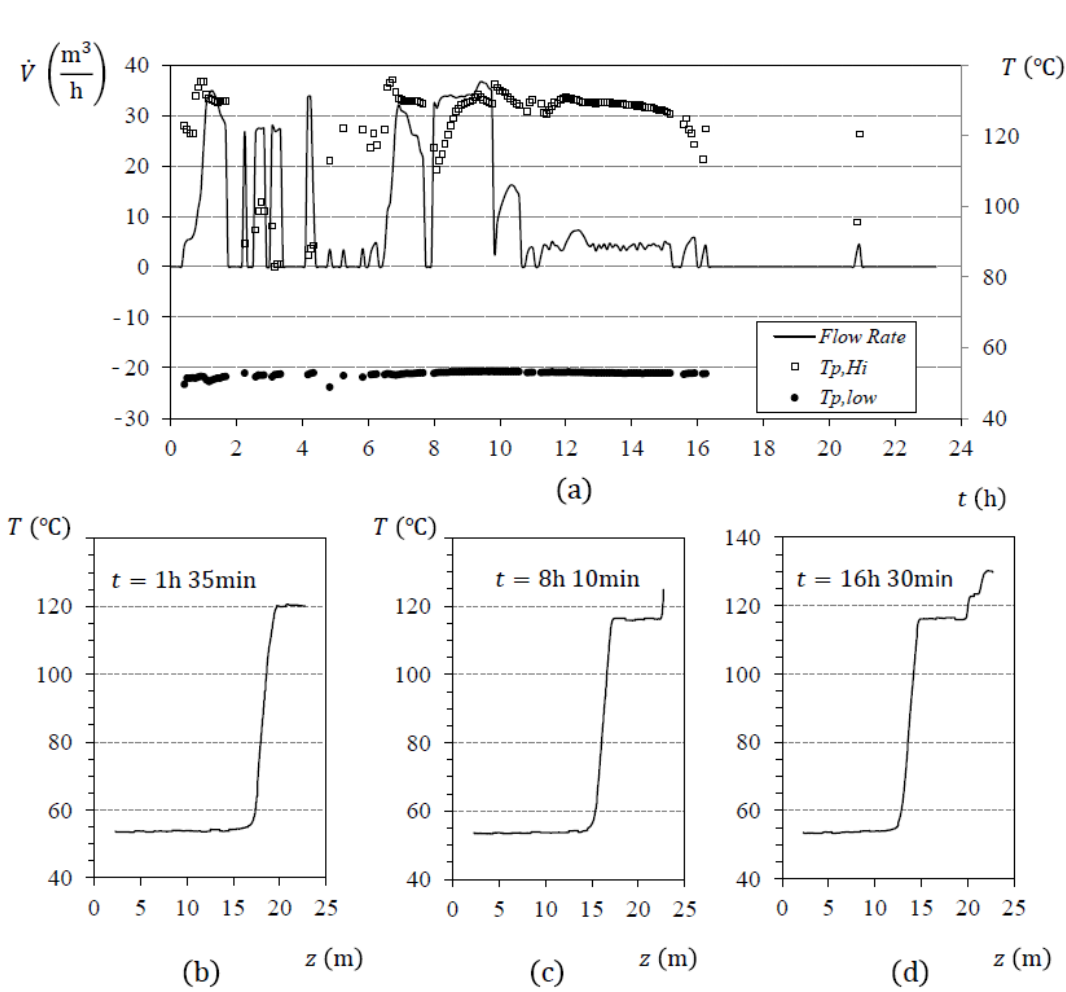
Figure 8. ( a ) Flow rate and pipe temperatures in a 24 h period with double temperature step generation. Temperature profiles at: ( b ) 1 h 30 min; ( c ) after 8 h; when colder water inlet promoted temperature decrease and sensor detects hotter water ( d ) after the formation of double temperature